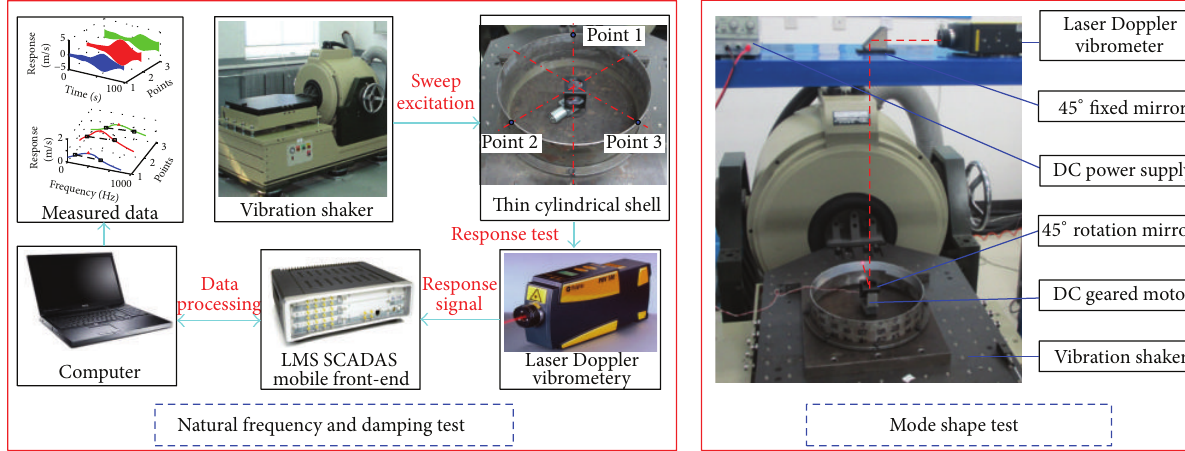
Figure 7: Schematic of test system of modal parameters of TCS under bolt looseness